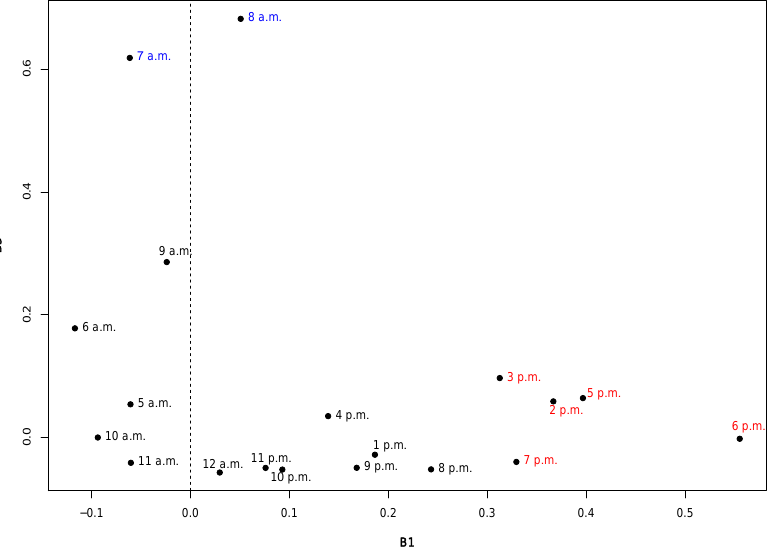
Figure 8. Loading plots (principal coordinates) for mode 2 (Timetable). Component 1 vs. Component 3 for mode